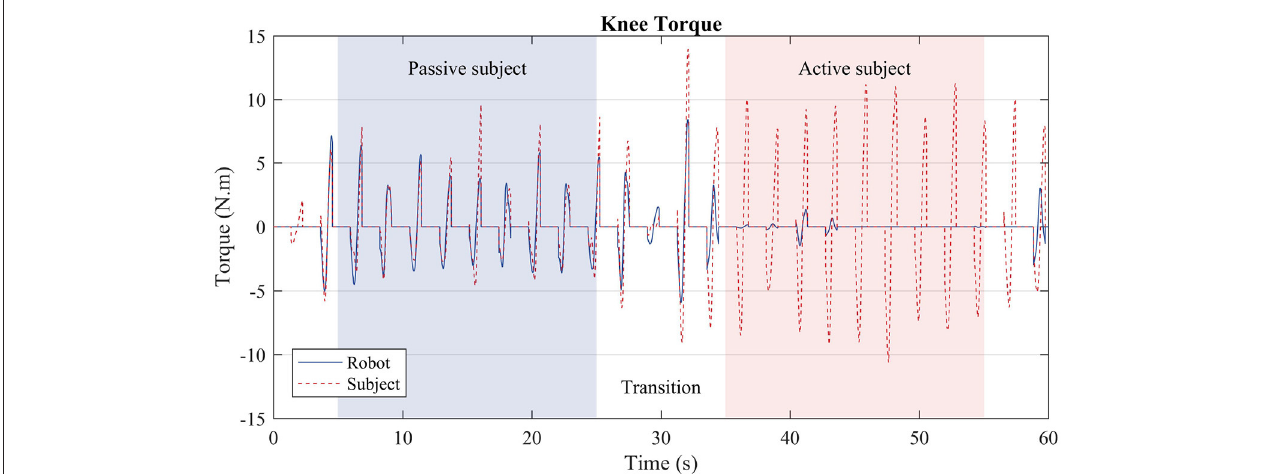
FIGURE 11 | Subject torque (red dashed lines) and robot torque (solid blue line) in the third test. During the first stage (blue region), the user was instructed to walk passively, i.e., the treadmill slowed down, and the subject prevented from moving more than necessary the knee joint of the right leg. During the second stage (red region), the user walked actively, i.e., as if he were not wearing the robot exoskeleton; thus, the robot produced considerably less